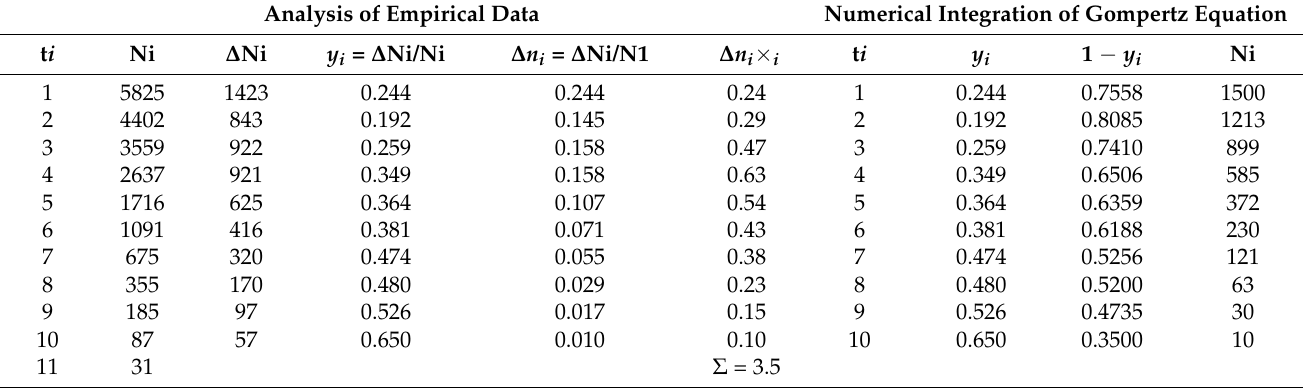
Table 2. Analysis of empirical data* for PLS forecasting using the Gompertz function. Analysis of Empirical